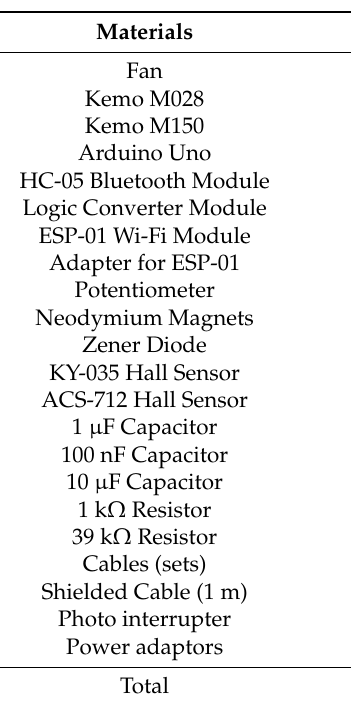
Table 1. Detailed inventory of the materials being necessary for basic system’s